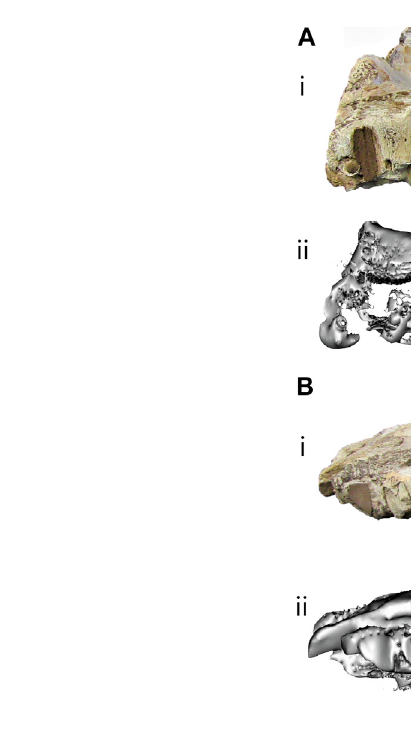
FIGURE 5 cf. Prognathodon muzzle unit (CGP/1/2265) in right lateral view (A) and left lateral view (B) photographs (i) and CT scans (ii) of the CGP/1/ 2265 muzzle unit. Nofunctional teeth presentinmaxilla, but toothsockets have been in fi lled presenting mould ofthird (RMT3) and fi fth (RMT5) right maxillaryteeth,andthird(LMT3) and fi fth(LMT5)leftmaxillaryteeth.Rightsidehas9maxillarytoothpositions,thirdand fi ftharenot visibleexcept on CTscan.Leftsidehas7maxillarytoothpositions,thirdonlyvisibleonCTscans,but fi fthvisibleexternallyasmaxillahasbrokenaway.Scalebar= 200